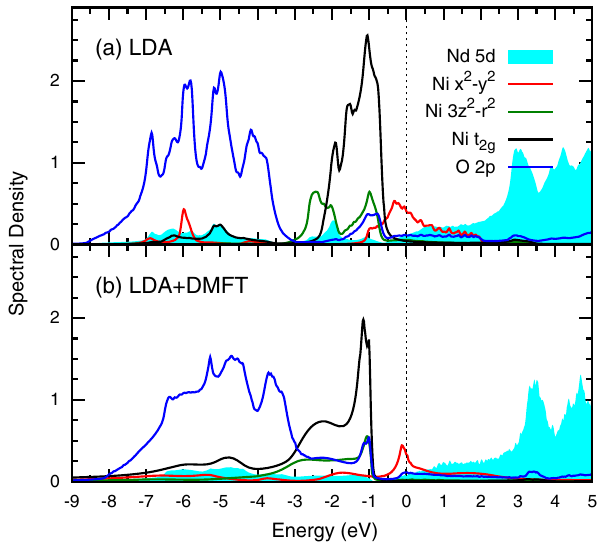
FIG. 1. The one-particle spectral densities of NdNiO 2 obtained